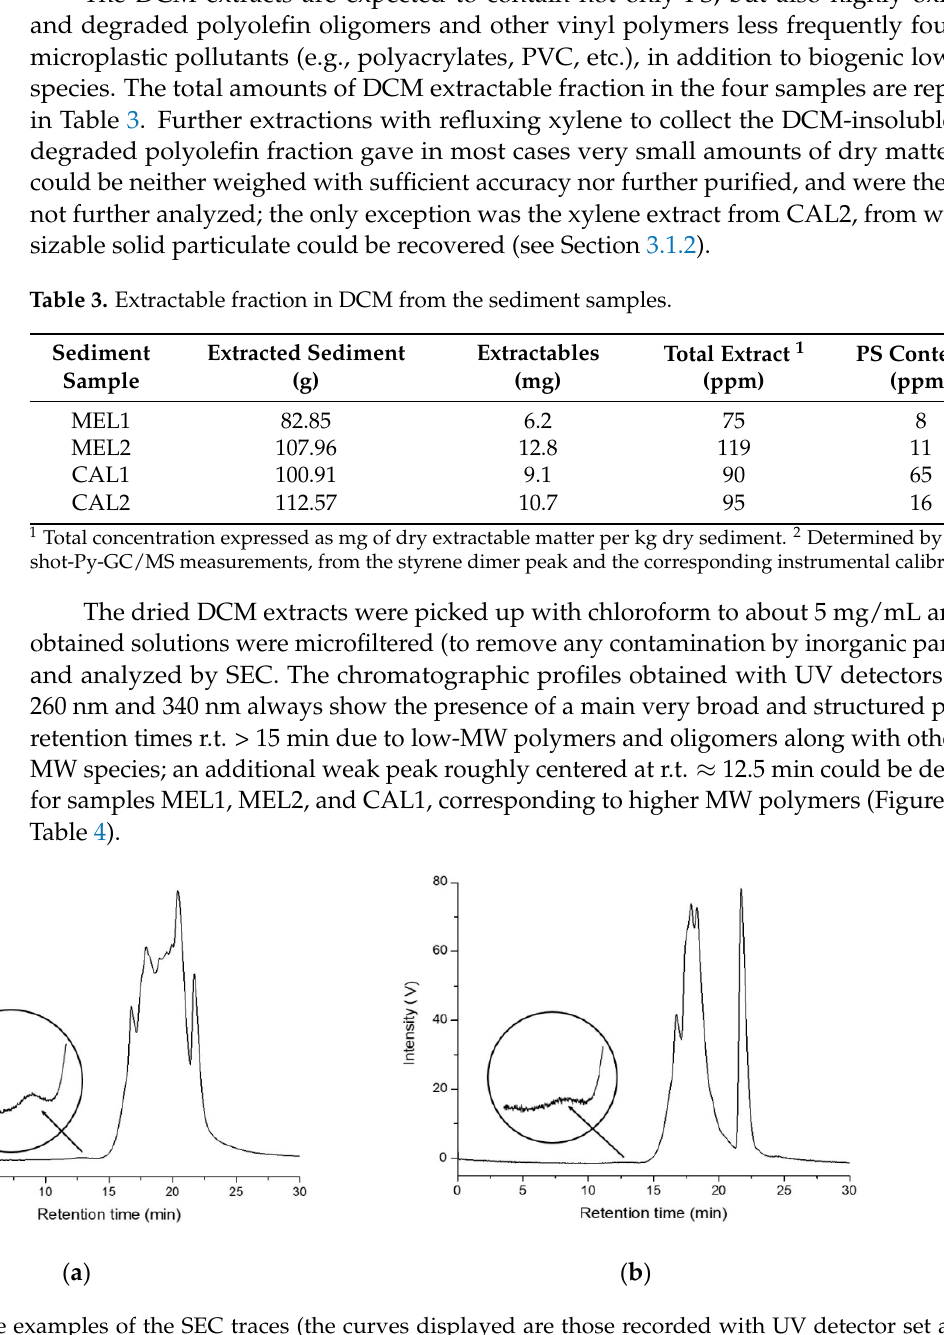
Figure 5. Representative examples of the SEC traces (the curves displayed are those recorded with UV detector set at 260 nm) for the DCM extractable fractions of: ( a ) MEL1; ( b )